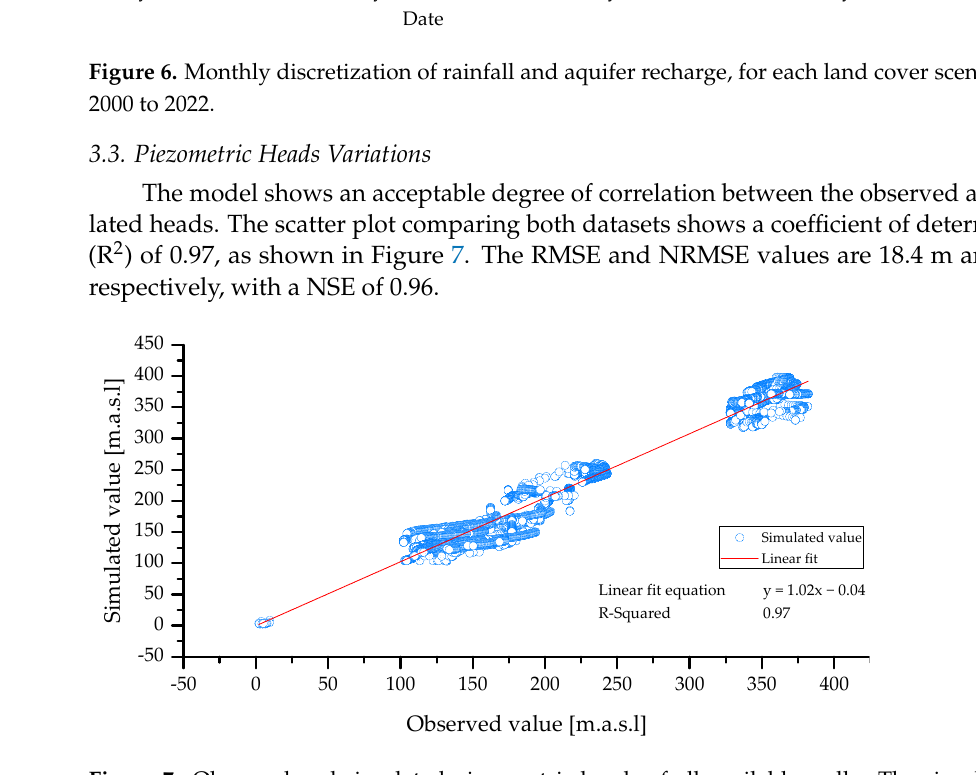
Figure 6. Monthly discretization of rainfall and aquifer recharge, for each land cover scenario from 2000 to 2022.